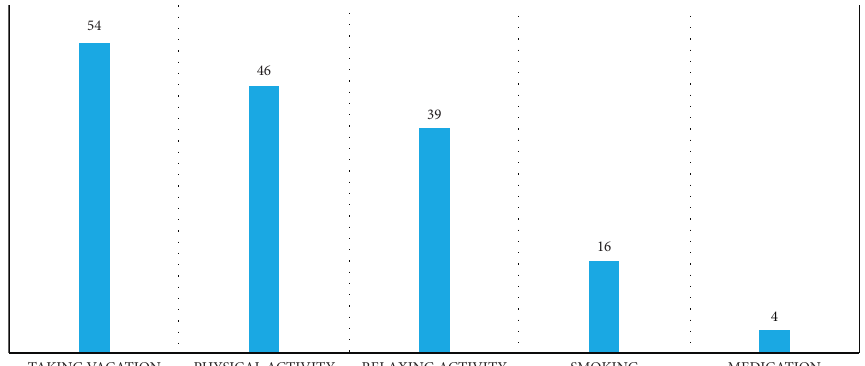
Figure 2: Factors identified by ICU staff that help cope with occupational